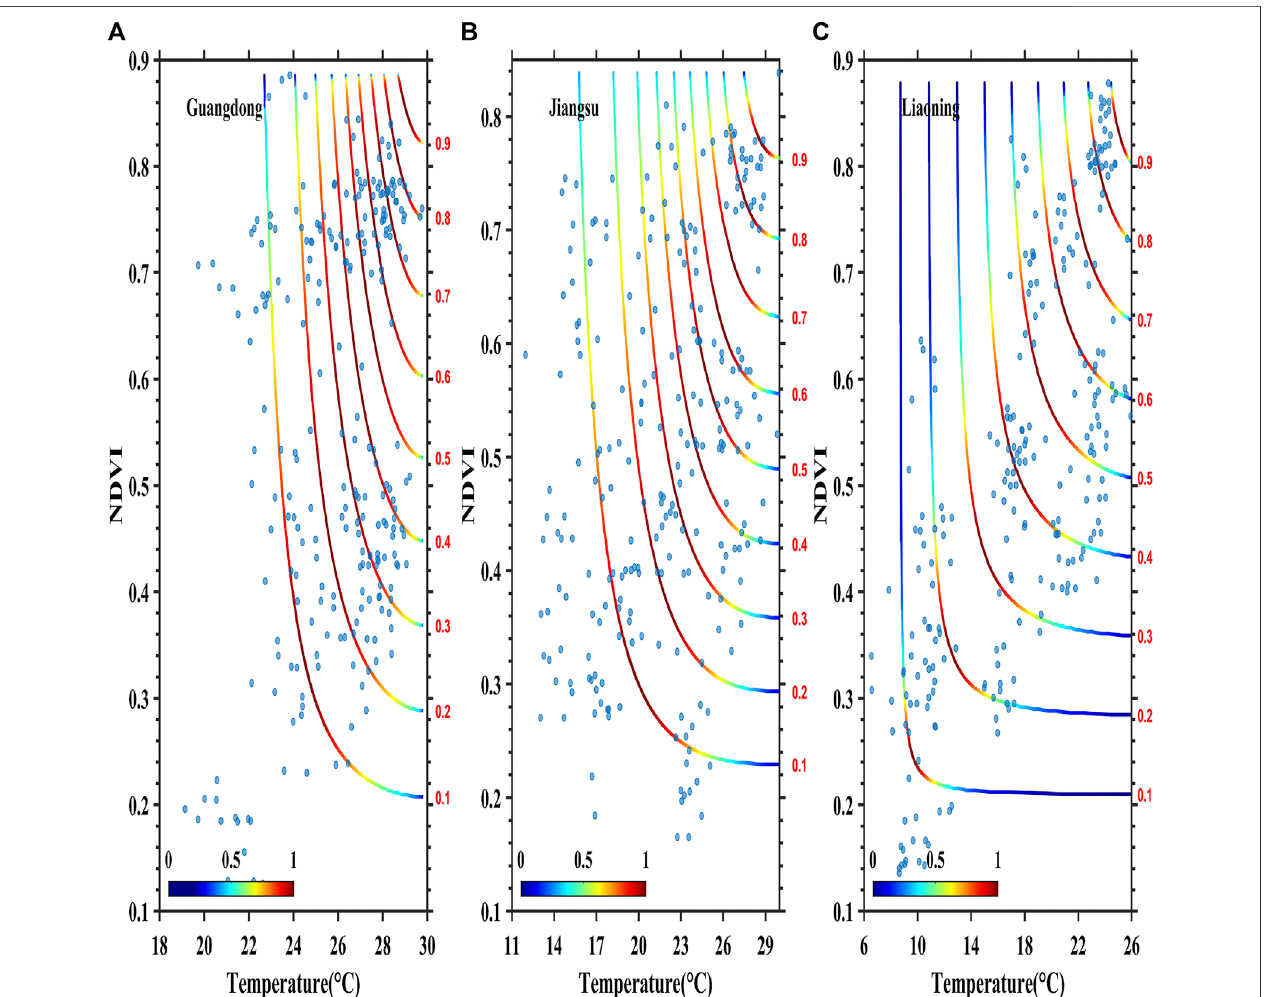
FIGURE 3 | Analysis of joint copulas of mean temperature-normalized difference vegetation index (NDVI) in (A) Guangdong, (B) Jiangsu, and (C) Liaoning.